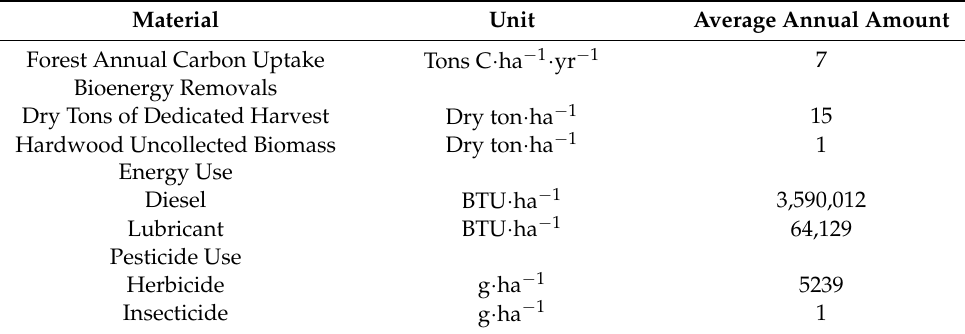
Table 1. LCI of the feedstock and harvesting production